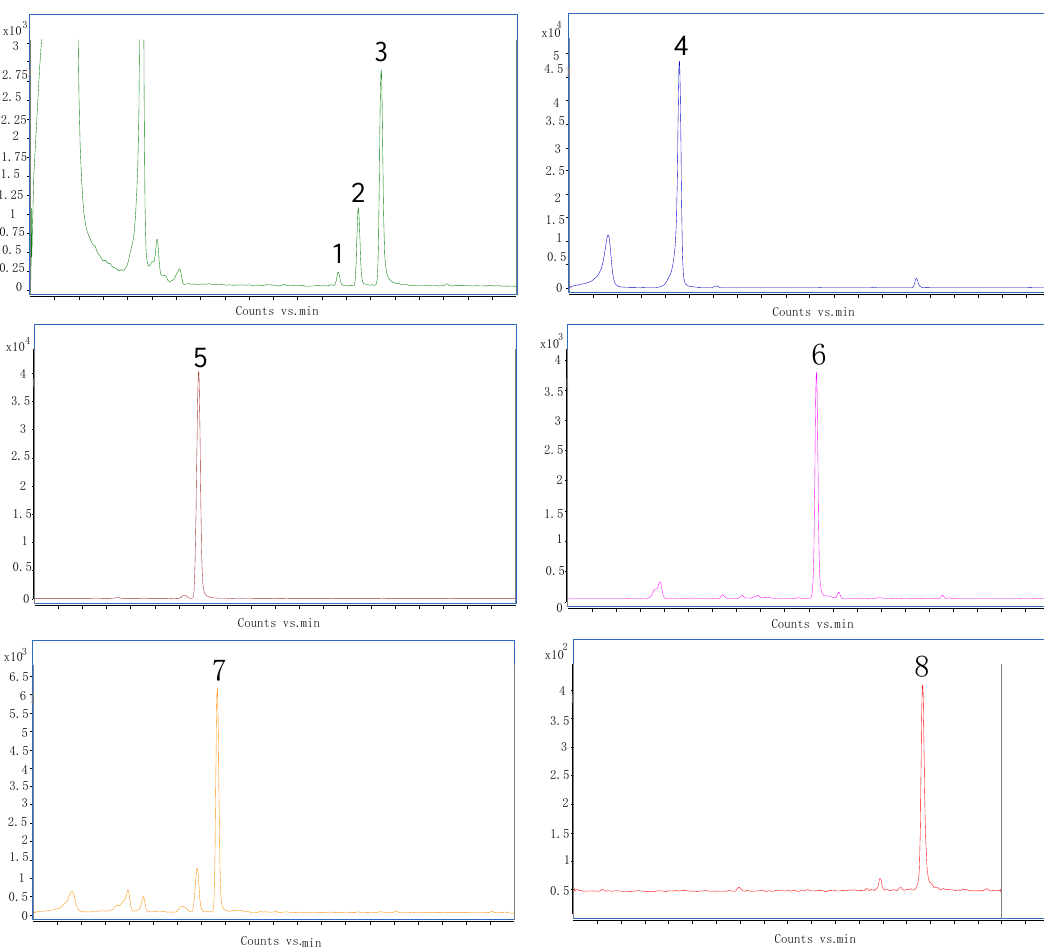
Figure 3. Chromatographic of chlorogenic acid standards. Note: 1. 3,4-dicaffeoylquinic acid 2. 3,5-dicaffeoylquinic acid 3. 4,5-dicaffeoylquinic acid 4. 3-caffeoylquinic acid 5. 4-caffeoylquinic acid 6. p -hydroxycinnamic acid 7. caffeic acid 8. 5-FQA.